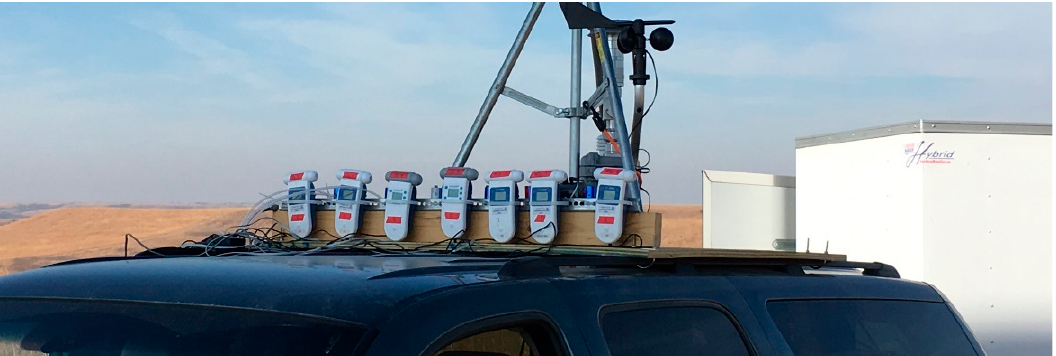
Figure 1. Photograph of Aeroqual and Cairpol sensors attached to the roof of the sampling vehicle from the March 2017 Konza study.